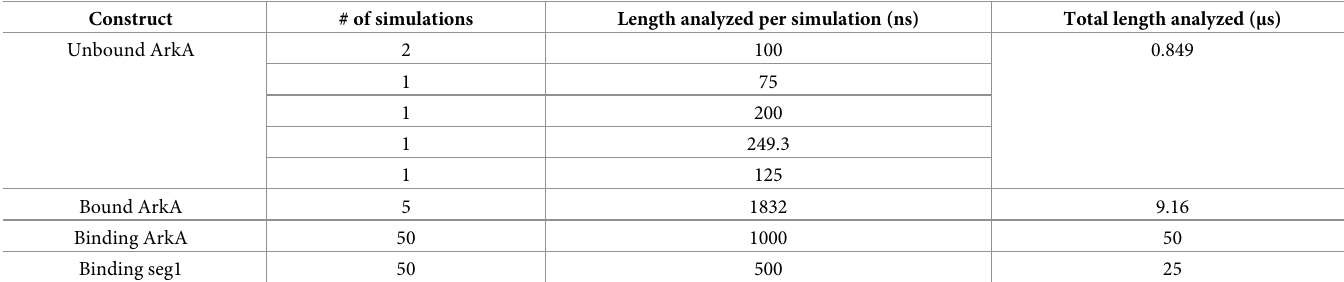
Table 1. Summary of simulations